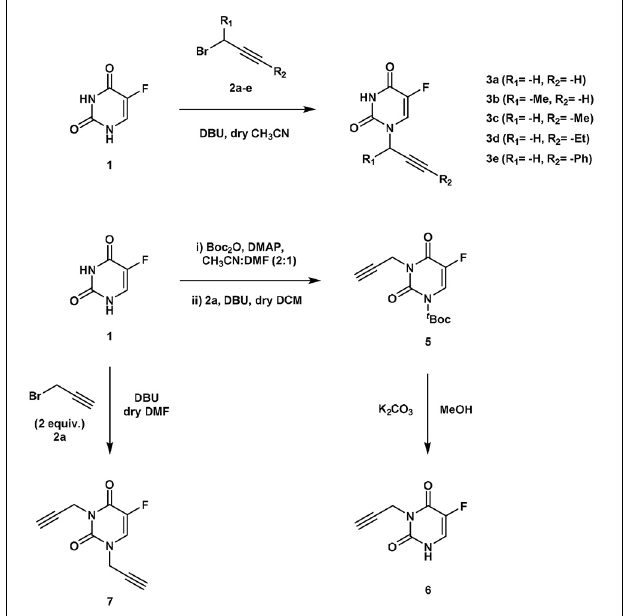
FIGURE 2 | Synthesis of compounds 3a-e (upper panel) and compounds 6, 7 (lower